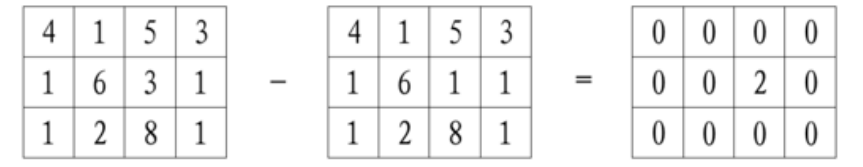
Figure 4. Image differencing